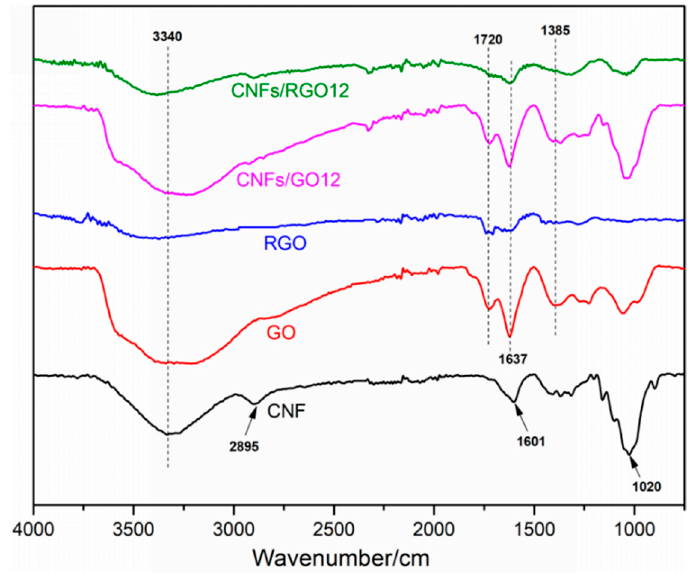
Figure 3. The FT-IR spectra of the CNF, GO, RGO, CNFs/GO 12 , and CNFs/RGO 12 films.